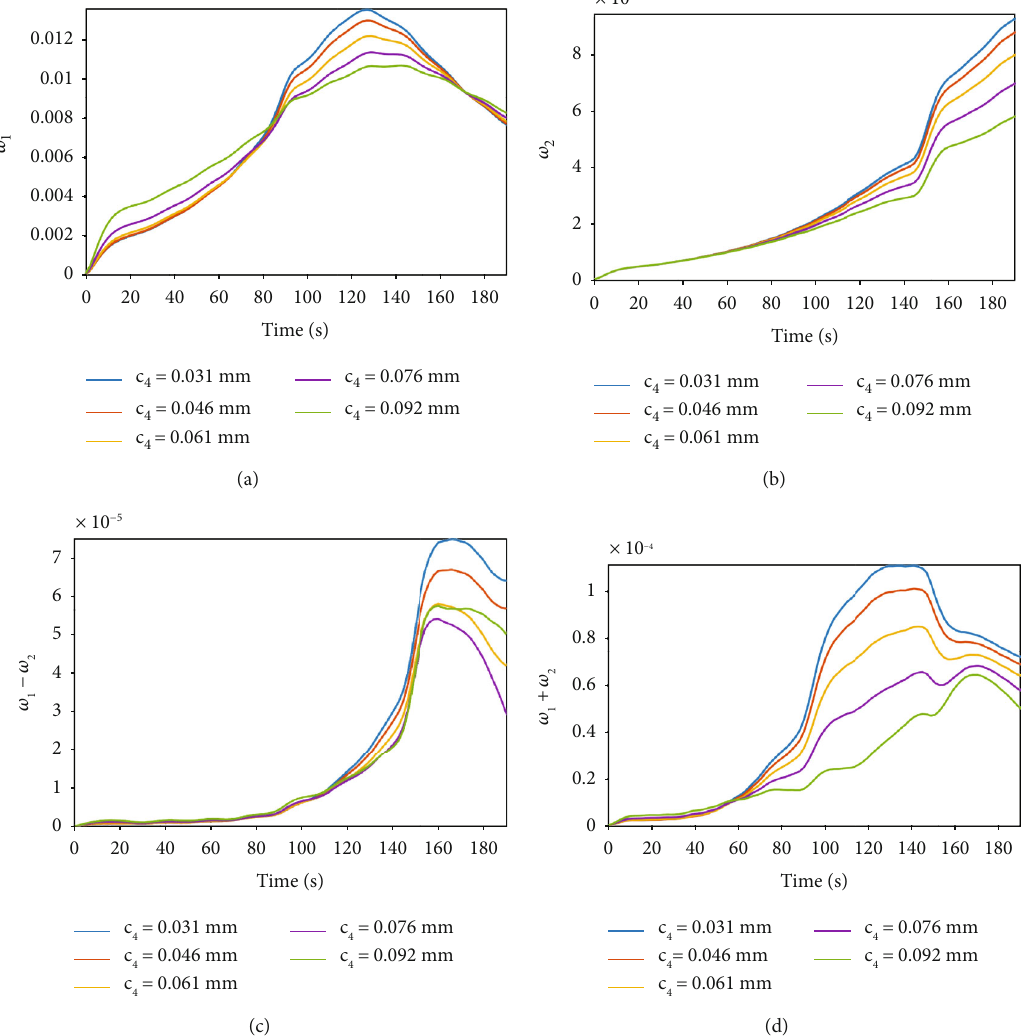
ω ω − ω ω + ω 1 ; (b) 2 ; (c) 1 2 ; (d) 1 2 .